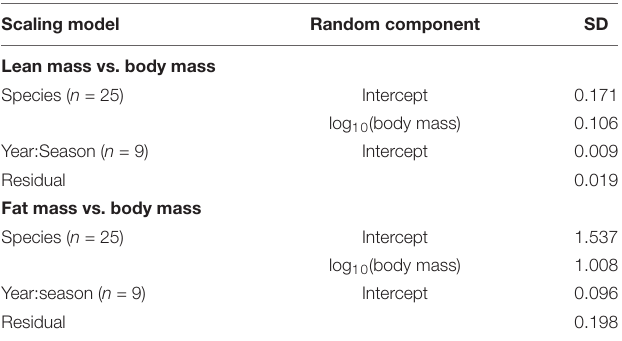
TABLE 4 | Random effects in scaling relationships with body mass for songbirds stopping over at Long Point, Ontario. Scaling model